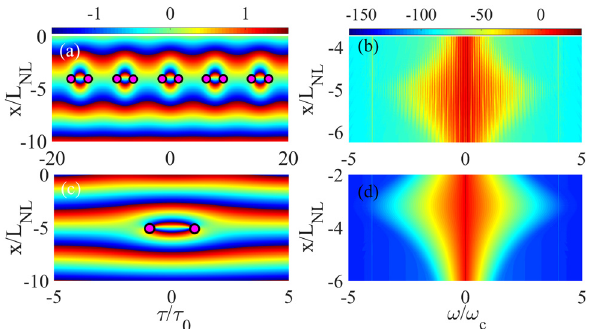
Figure 2: Panel (a) represents the phase dynamics of NSPPs through Akhmediev breather formation and panel (b) denotes corresponding spectral analysis. Panel (c) depicts the phase dynamics of NSPP through plasmonic peregrine wave and panel (d) represents its = 10 μ W, 𝜏 = 10 μ s, spectral evolution. For this figure P 0 0 𝛿𝜔 = 1 MHz, u = 0 . 08 MHz. Panels (a) and (b) are plotted for N modulation parameter a = 0 . 32 and for panels (c) and (d) we choose a = 0 . 5. Magenta dots in panels (a) and (c) represent the coordinates of PSs. Other parameters are given in the